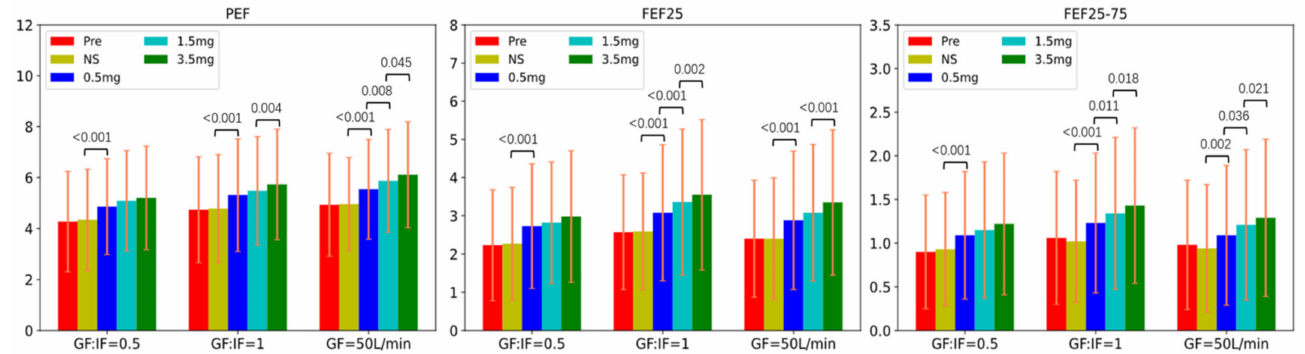
Figure 4. The results of PEF, FEF 25 , and FEF 25–75 after inhaling saline and salbutamol via HFNC at different nominal doses in three groups. In the group of GF:IF = 0.5, all the spirometry results were higher after inhaling salbutamol at 0.5 mg, compared to that with saline inhalation. However, in the groups of GF:IF = 1.0 and GF = 50 L/min, PEF, FEF 25 , FEF 25–75 continued increasing after inhaling salbutamol via HFNC at the cumulative doses of 0.5 mg, 1.5 mg and 3.5 mg. HFNC, high-flow nasal cannula; GF, gas flow; IF, inspiratory flow; PEF, peak expiratory flow; FEF 25 , forced expiratory flow at 25% of forced vital capacity; FEF 25–75 , forced expiratory flow at 25% to 75% of forced vital